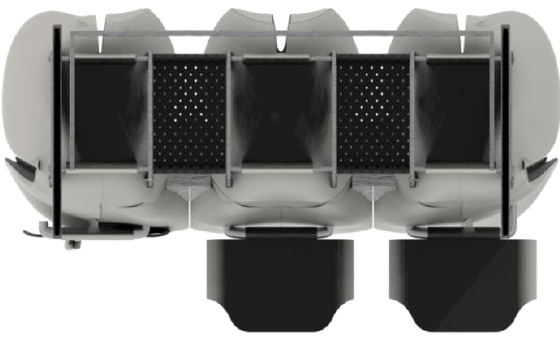
Figure 43. Bottom view of final product.